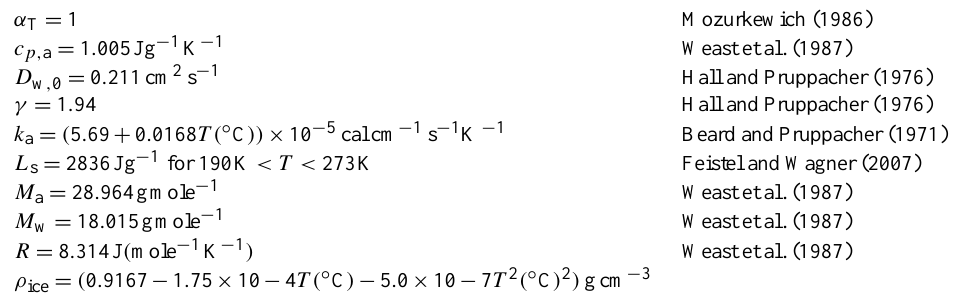
Table B1. Physical quantities used in SIGMA. α T =